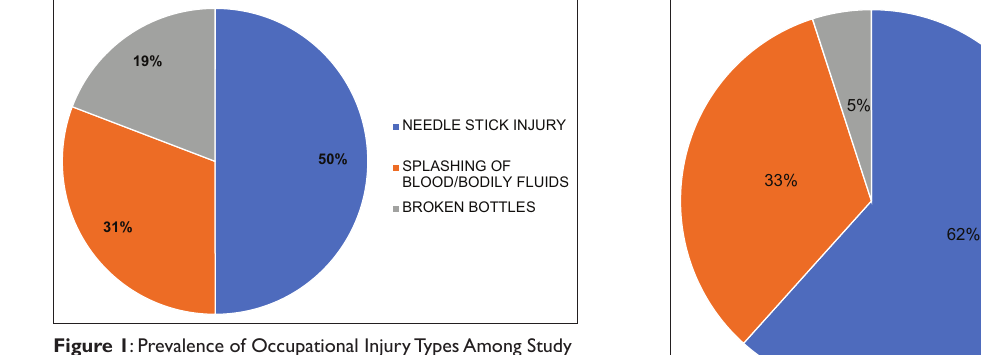
Among those who had needle stick injury, nurses